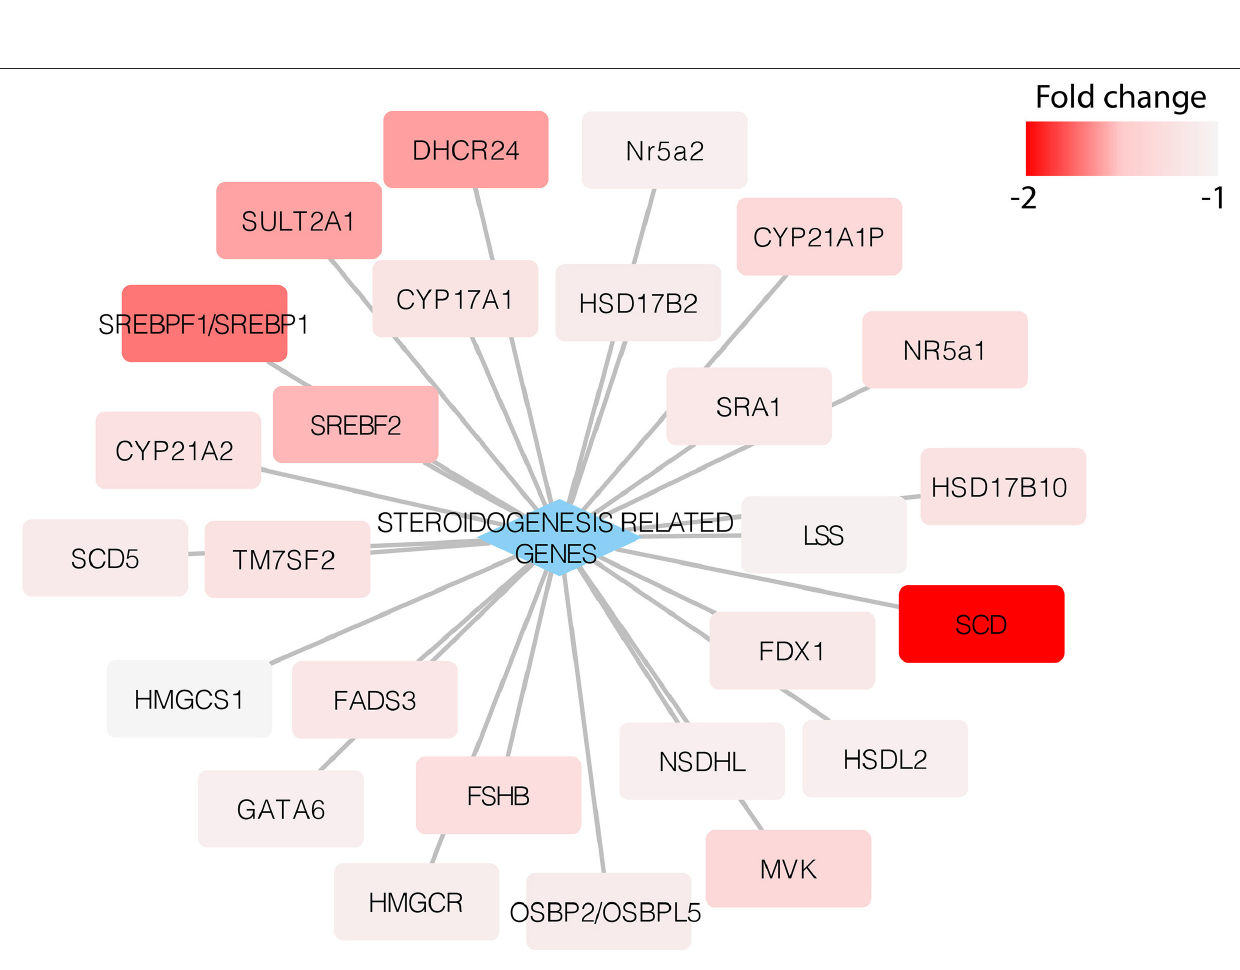
Frontiers in Endocrinology |